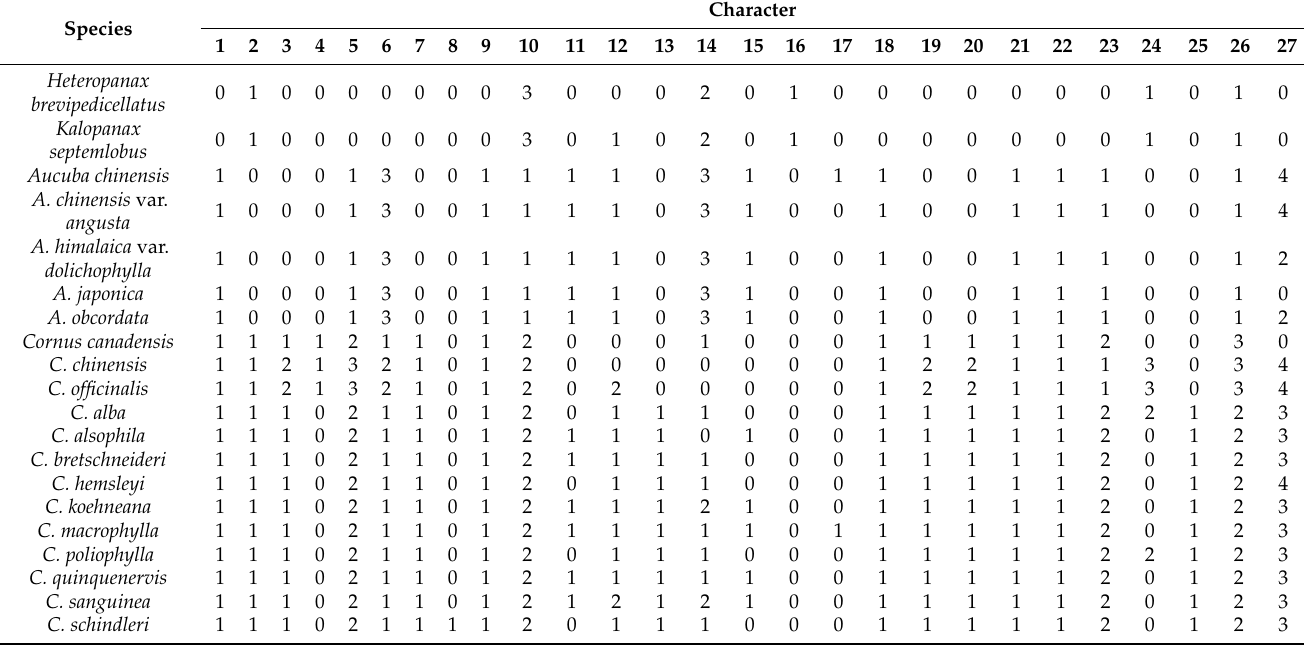
Table 3. Data matrix of fruit characters used in the phylogenetic analysis of Chinese Cornaceae species and related taxa. Characters and states are described in Table 2. Characters 1–4 from Flora of China